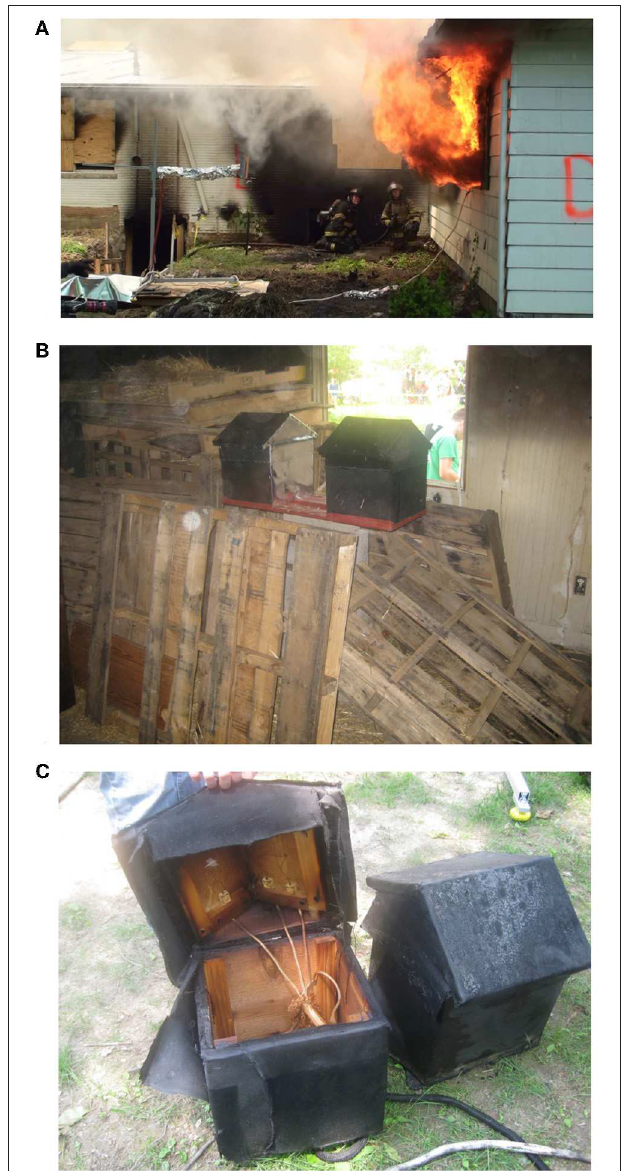
FIGURE 2 | The burn-room experiment in Avon Lake, Ohio experiment. (A) The fire gushes through the window toward a temperature and heat-flux sensor stand (left), (B) the blanketed wooden model structures surrounded by palettes before ignition. Left: metallic polyester coated amorphous silica (AAS1800) and right: pre-oxidized carbon fiber (CK-3), and (C) the structures after fire exposure (left: CK-3 and right: